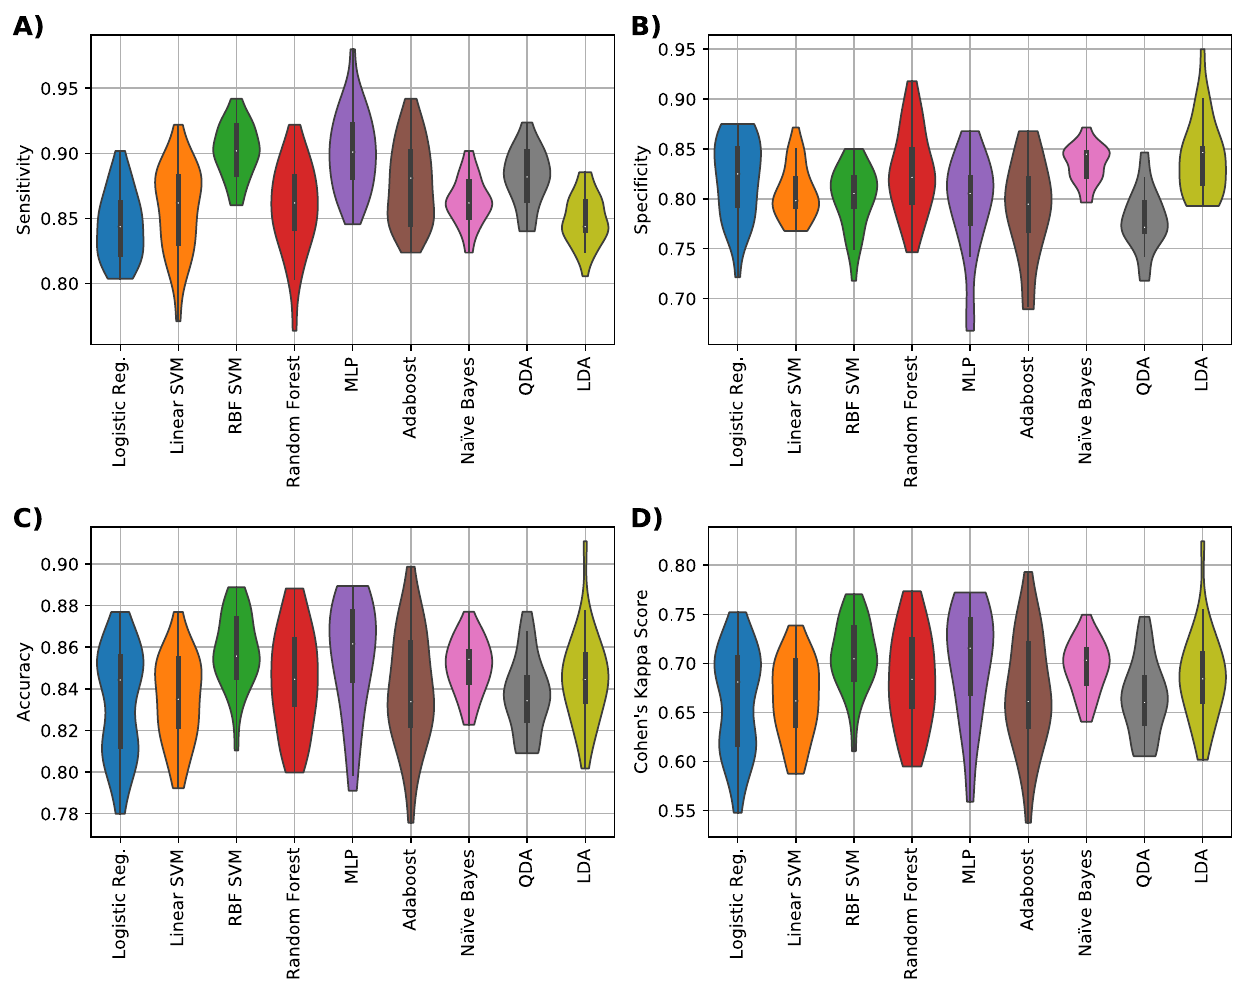
Figure 3. Performance metrics results for the data set composed with the features acquires from the binning scheme. ( A ) Sensitivity, ( B ) Specificity, ( C ) Accuracy and ( D ) Cohen’s kappa values of nine different classifiers (logistic regression, linear SVM, RBF SVM, random forest, MLP NN, Adaboost, QDA and LDA) are